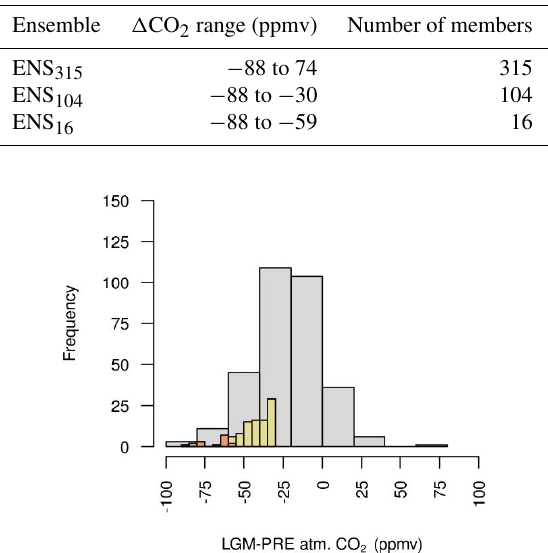
Figure 1. LGM change in atmospheric CO 2 distribution. The ENS 315 response is shown in grey, the ENS 104 ensemble response in yellow and the ENS 16 ensemble response in orange. The same colour legend applies to all figures in the